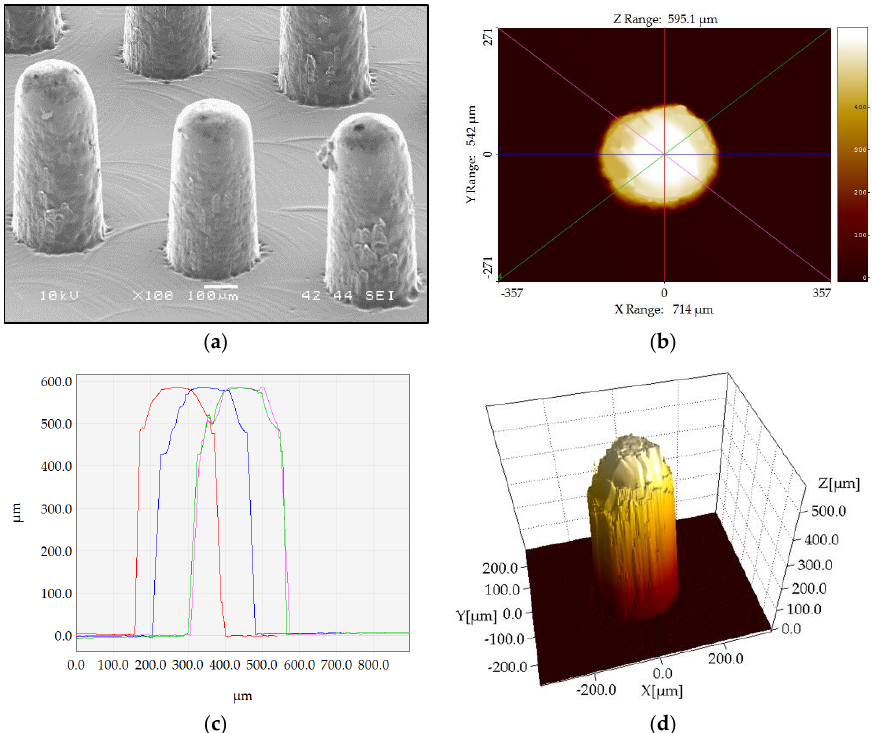
Figure 7. ( a ) SEM 3D image of the pillars and ( b – d ) pillar height measurement procedure, ( b ) step 1: extracting cros-section profiles, ( c ) step 2: assessing pillar height from the four extracted profiles as indicated by different color, and ( d ) 3D representation of the pillar [5].